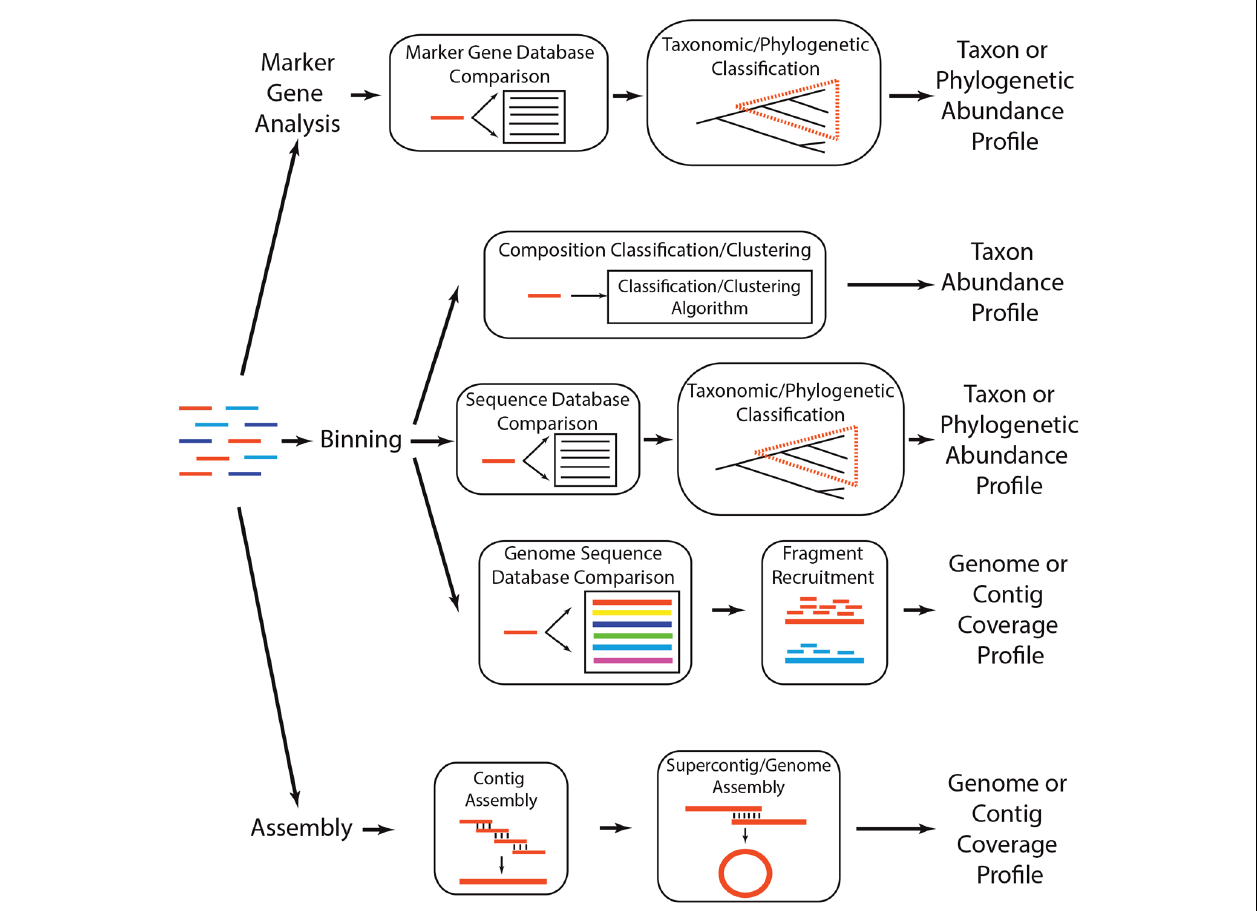
metagenomes, including (1) compositional binning, which uses sequence composition to classify or cluster metagenomic reads into taxonomic